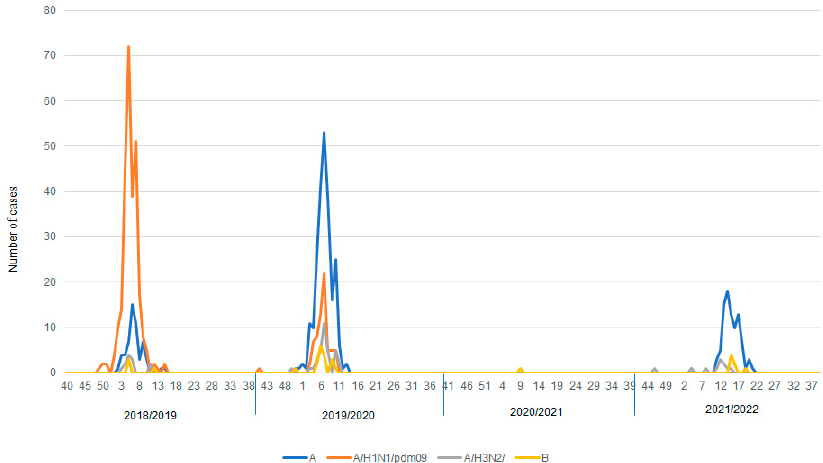
Figure 3. Predomination of in fl uenza types and subtypes in the last four epidemic seasons.